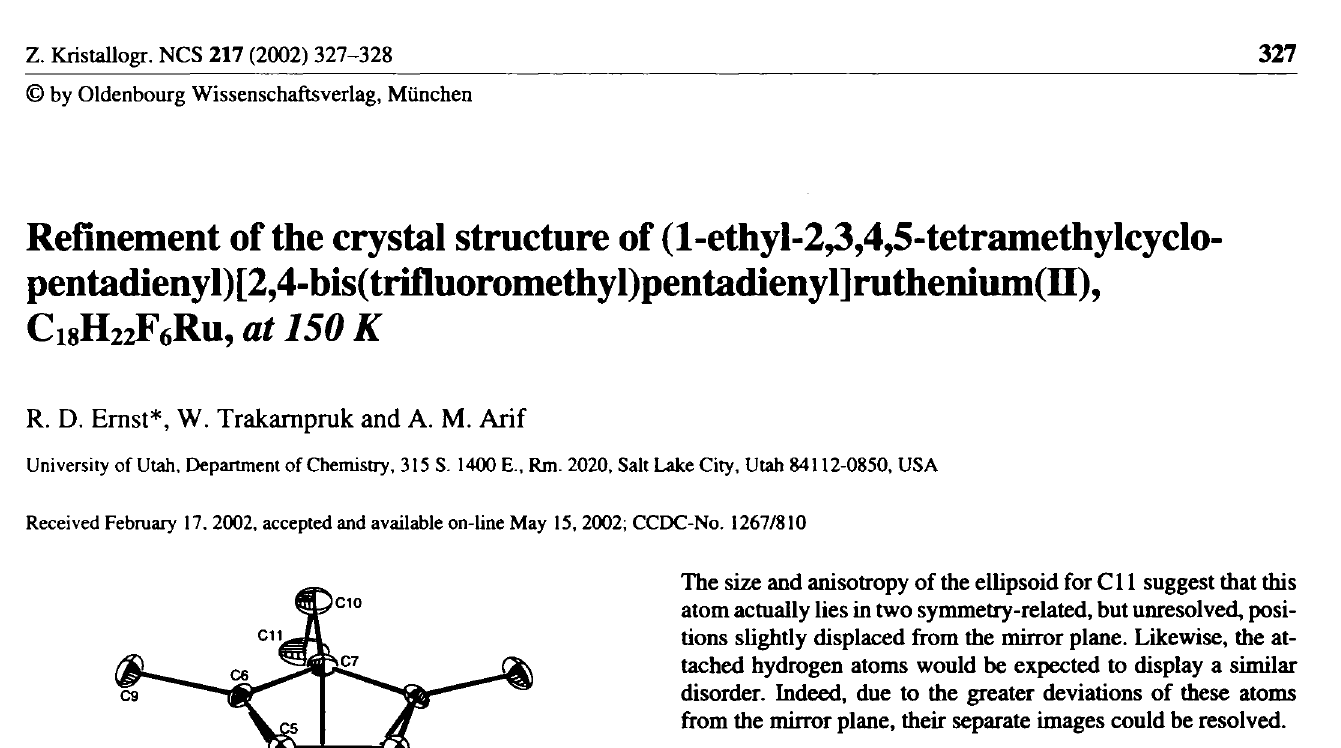
Table 1. Data collection and handling.